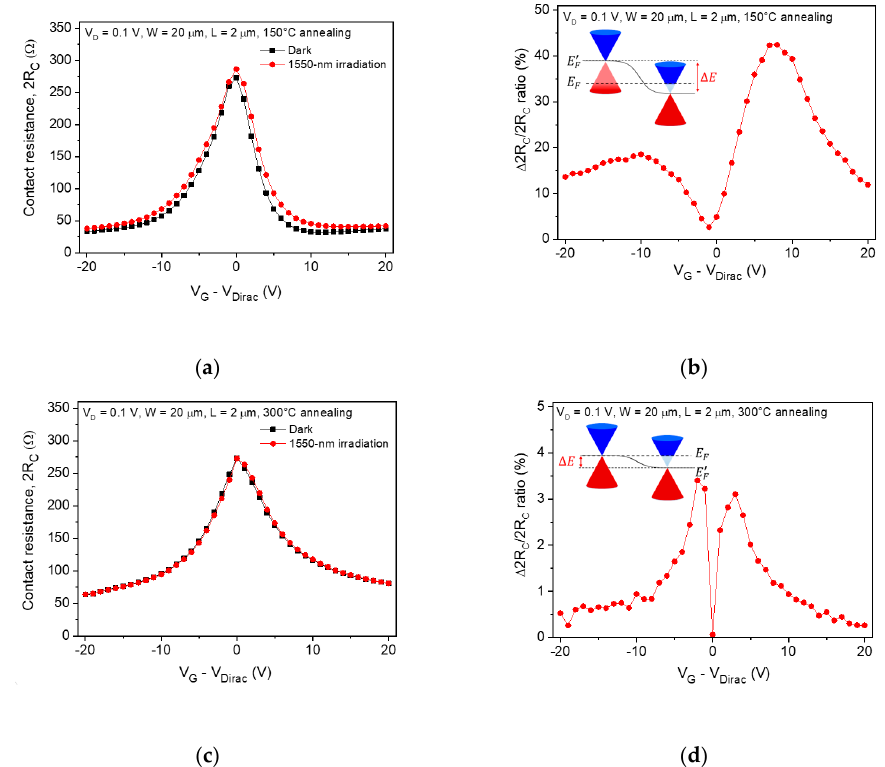
Figure 4. Contact resistance as a function of gate bias extracted from the total device resistance measured after ( a ) 150 °C and ( c ) 300 °C annealing under dark and illuminated conditions. ( b ), ( d ) The change ratio in the contact resistance as a function of gate bias calculated from ( a ) and ( c ), respectively. Inset: band diagrams in the junction between the channel graphene (left) and graphene near the metal contact (right). The Fermi energy level (E F ) and graphene Dirac point energy level (E ’ F ) are illustrated by the dashed and solid lines,